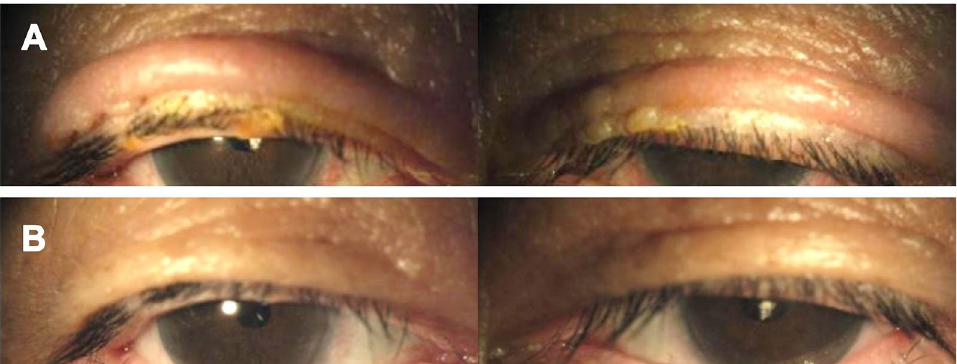
Figure 4. The signs of periorbital dermatitis. ( A ) Bilateral eczematous periorbital swelling after using the preservative-free dorzolamide/timolol eye drops, ( B ) improved swelling 3 weeks after cessation of the eye